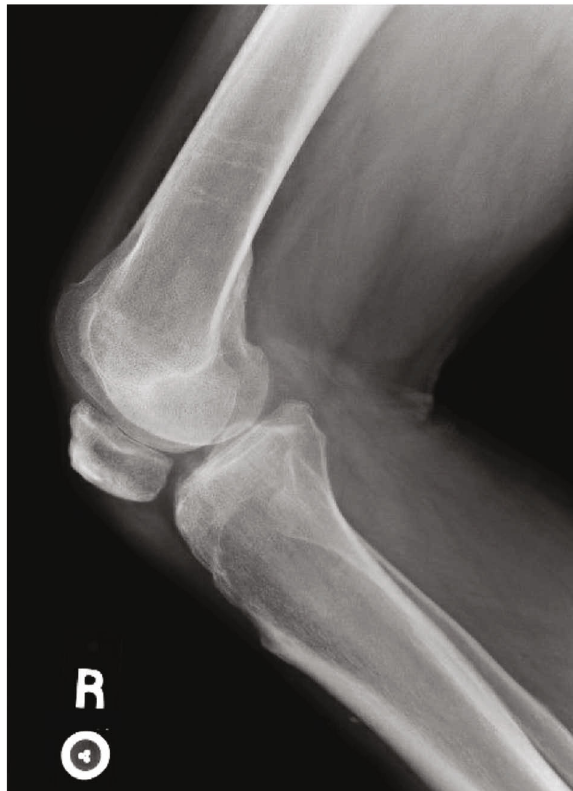
Figure 2: Patient 2 lateral X-ray showing signi fi cant radiographic patellar baja but no signi fi cant bony injury.